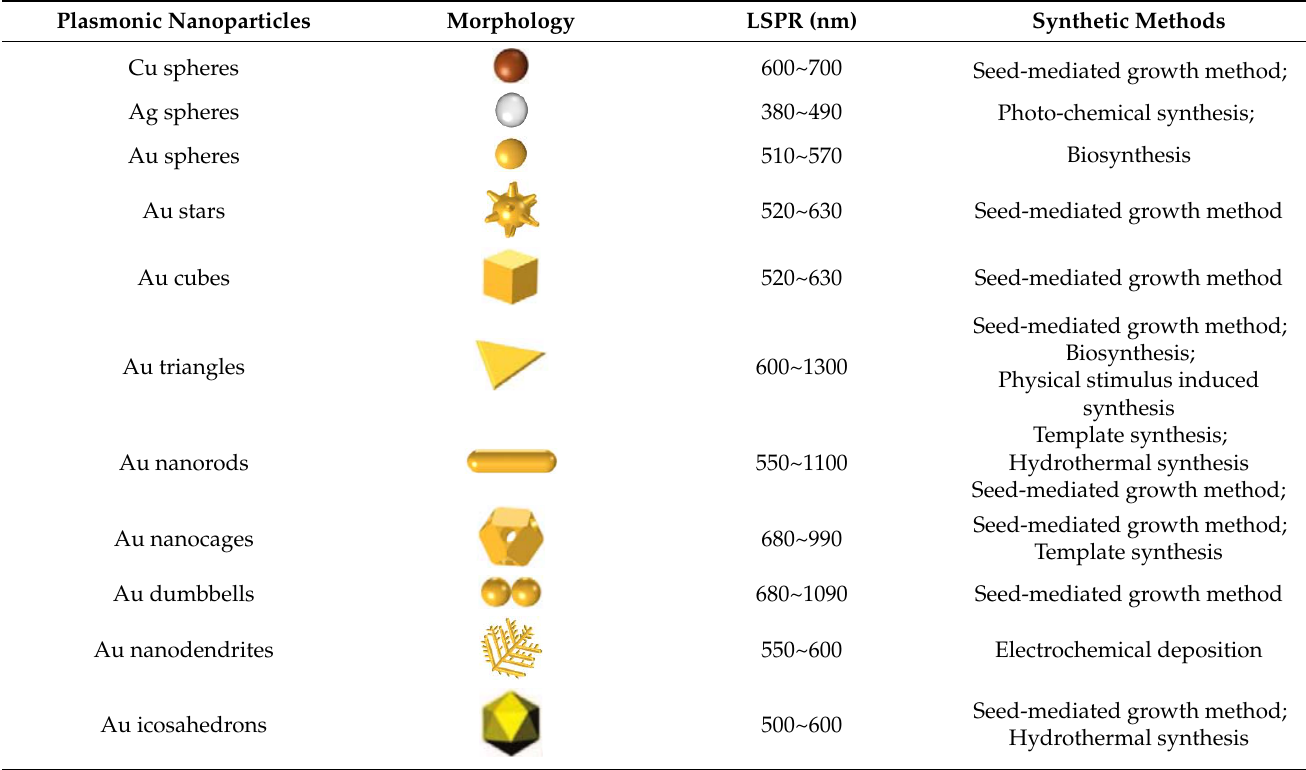
Table 1. Summary of the morphology, LSPR, and synthetic methods of some reported plasmonic metal nanostructures. The pictures in Table 1 were obtained from the literature with slight modifications.